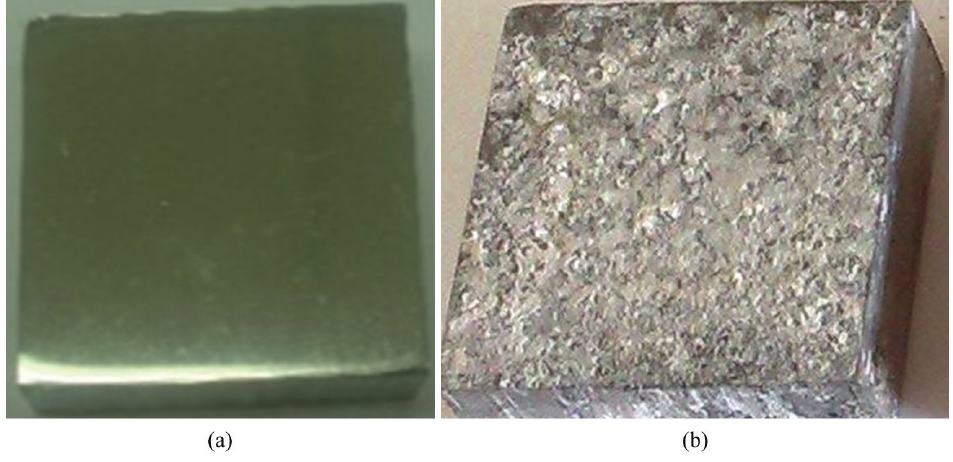
Figure 8. (a) Surface of the untreated sample before the test and (b) after 145 h of exposure to salt spray.